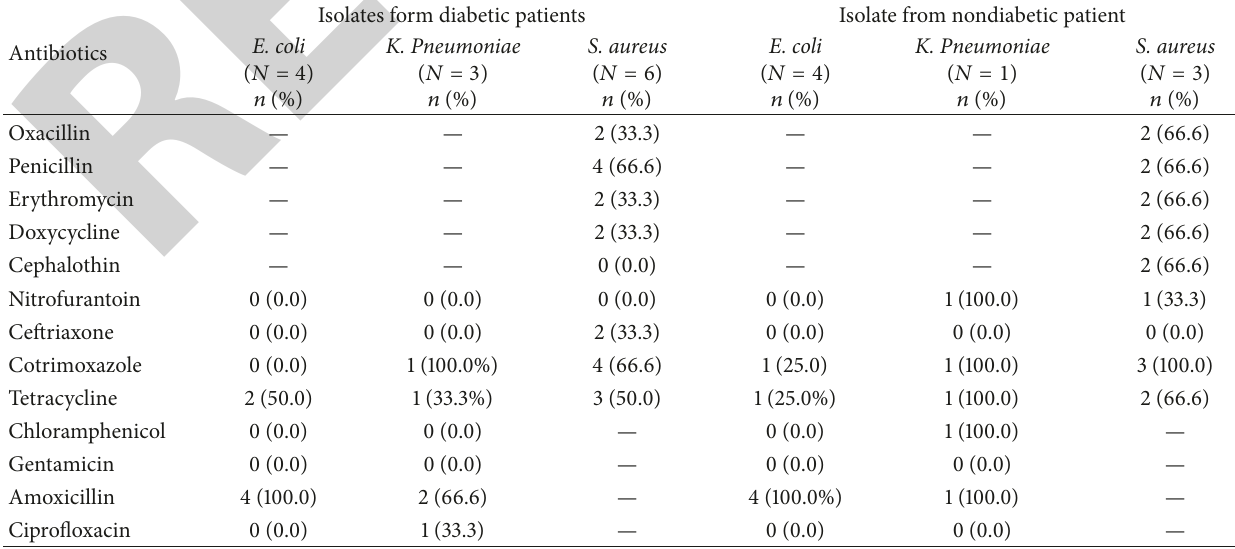
Table 8: Comparison of antimicrobial resistance pattern of common bacterial isolates from urine of diabetic and nondiabetic patients attending Debre Tabor Hospital, Northwest, Ethiopia,